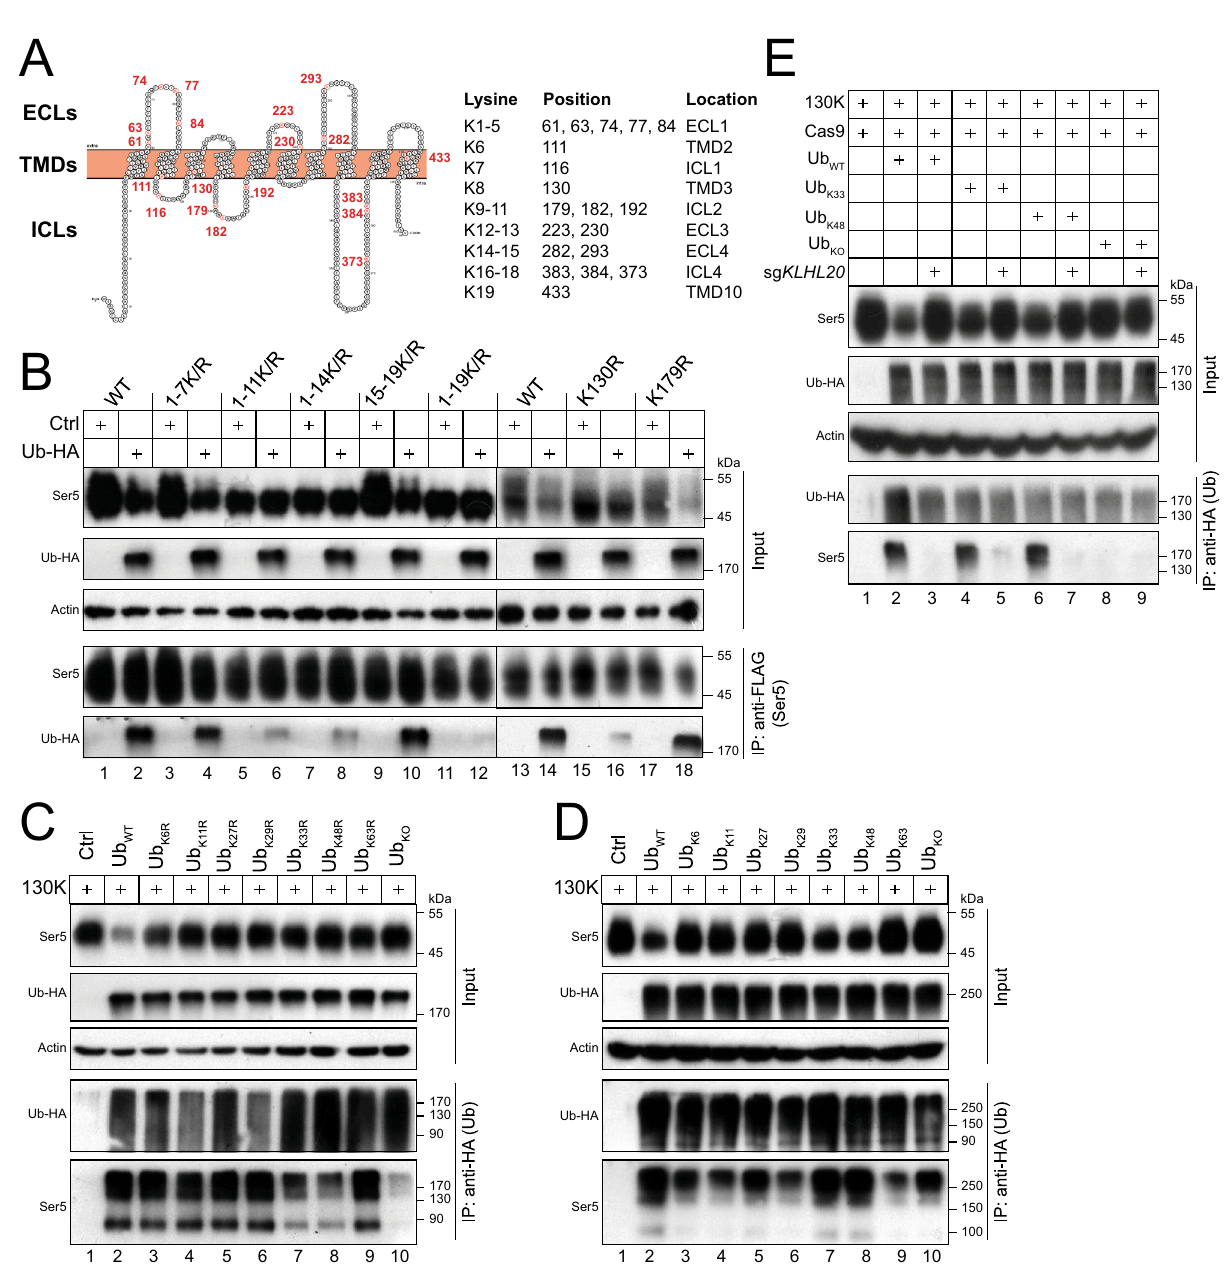
Fig. 2 Identi fi cation of lysine 130 (K130) as a critical polyubiquitination site on SERINC5. A A Ser5 membrane topology model is presented. Five ECLs, 10 TMDs, and 4 ICLs are indicated. Nineteen lysine residues (K1 to K19) are numbered and colored in red. Their distributions into these regions are indicated. Their positions in Ser5 protein are also indicated. The Ser5 membrane topology was predicted by the on-line transmembrane hidden Markov model (TMHMM, v2.0) (https://services.healthtech.dtu.dk/service.php?TMHMM-2.0) and the model was generated by Protter (http://wlab.ethz.ch/ protter/start/). ECL, extracellular loop; TMD, transmembrane domain; ICL, intracellular loop. B Ser5 and its lysine mutants were expressed with Ub in HEK293T cells. Ser5 was immunoprecipitated by anti-FLAG and levels of polyubiquitinated Ser5 were compared by WB. C The Ser5-130K mutant (130 K) was expressed with Ub and its mutants bearing indicated K-to-R mutations in HEK293T cells. Ectopic Ub was immunoprecipitated by anti-HA and levels of polyubiquitinated Ser5 were compared by WB. D The 130 K mutant was expressed with indicated Ub mutants in HEK293T cells. Ectopic Ub was immunoprecipitated by anti-HA and levels of polyubiquitinated Ser5 were compared by WB. E The 130 K mutant was expressed with indicated Ub mutants in HEK293T cells in the presence or absence of KLHL20 -KD. Ectopic Ub was immunoprecipitated by anti-HA and levels of polyubiquitinated Ser5 were compared by WB. All experiments were repeated at least twice, and similar results were obtained. Source data are provided as a Source Data fi